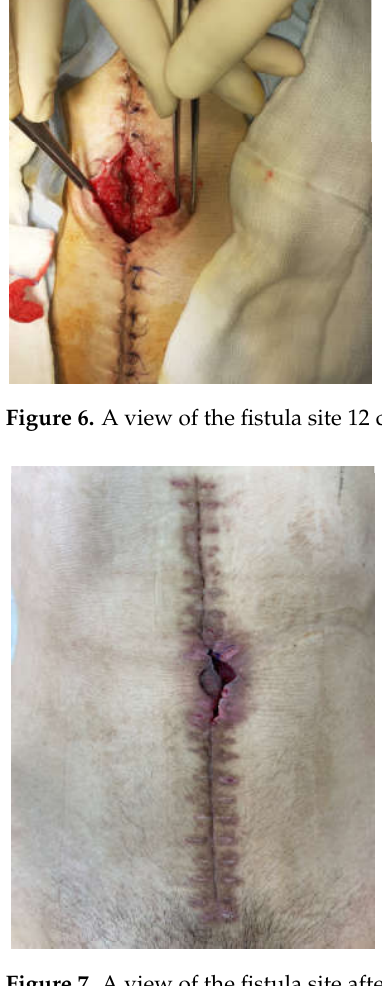
Figure 7. A view of the fistula site after 26 days, at that time colostomy bag was applied.